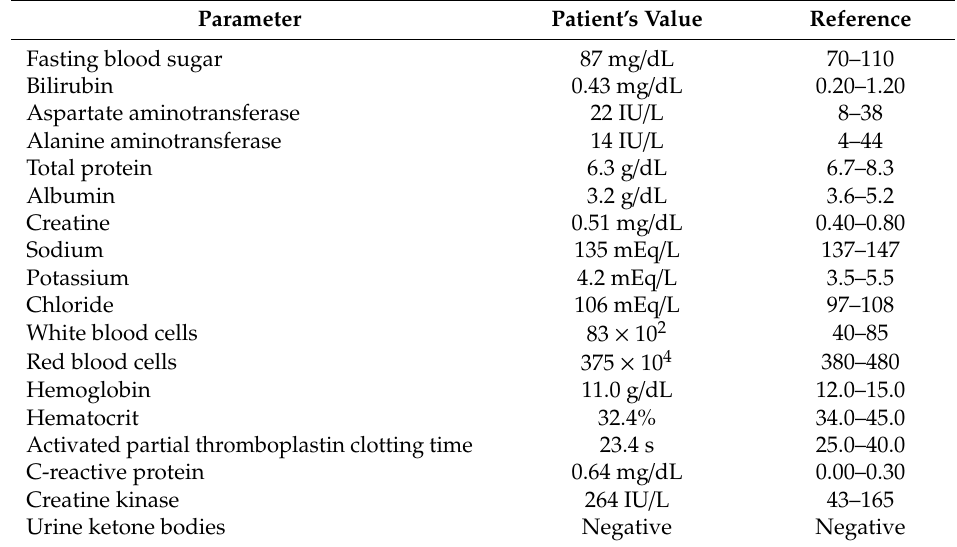
Table 2. Maternal biochemical and hematological parameters during the 34th week of gestation (3 weeks after intermittent fasting and 7 weeks after dietary